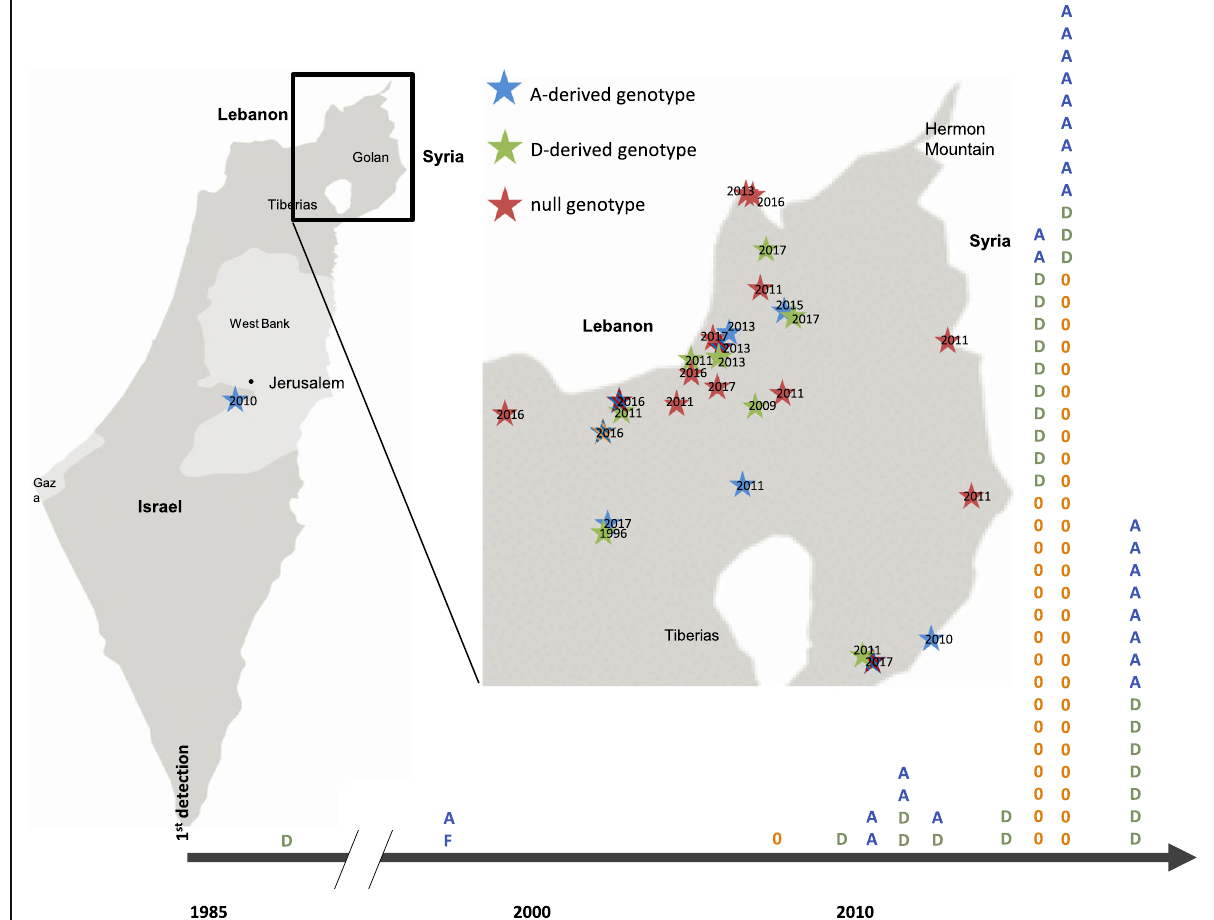
Fig. 8 Geographical distribution and timeline of the appearance of A- and D-derived genotypes in Israel in the timeframe 1987 – 2018. Striped stars indicate the presence of two genotypes in one geographical location. The null PCR genotype (labelled as 0 in the timeline) is indicated in